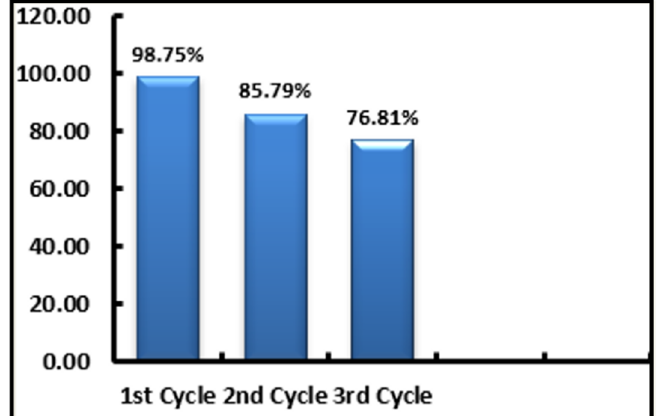
Figure 10. Photodegradation of malachite green dye in cyclic run.